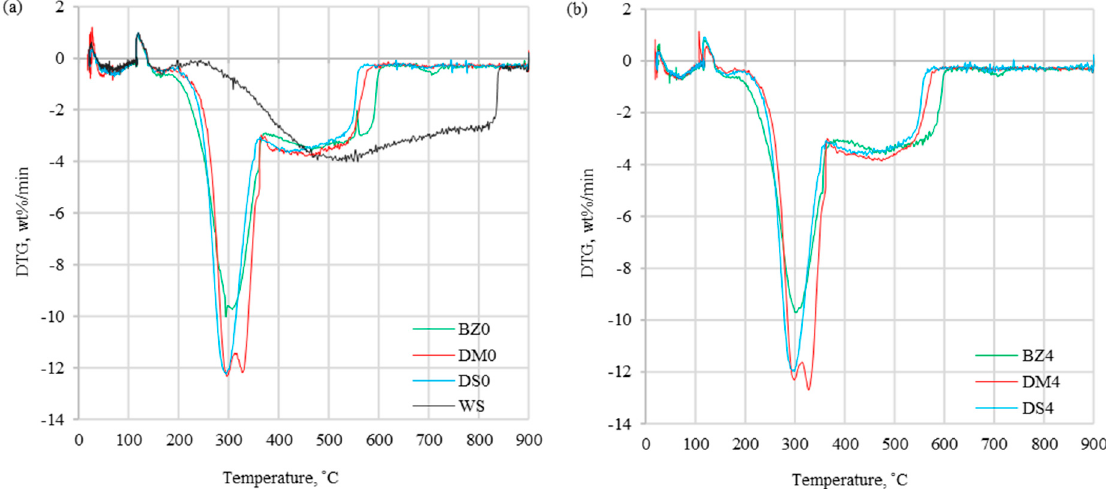
Figure 2. DTG curves for ( a ) fuels without halloysite and ( b ) fuels with halloysite at β = 20 °C/min.